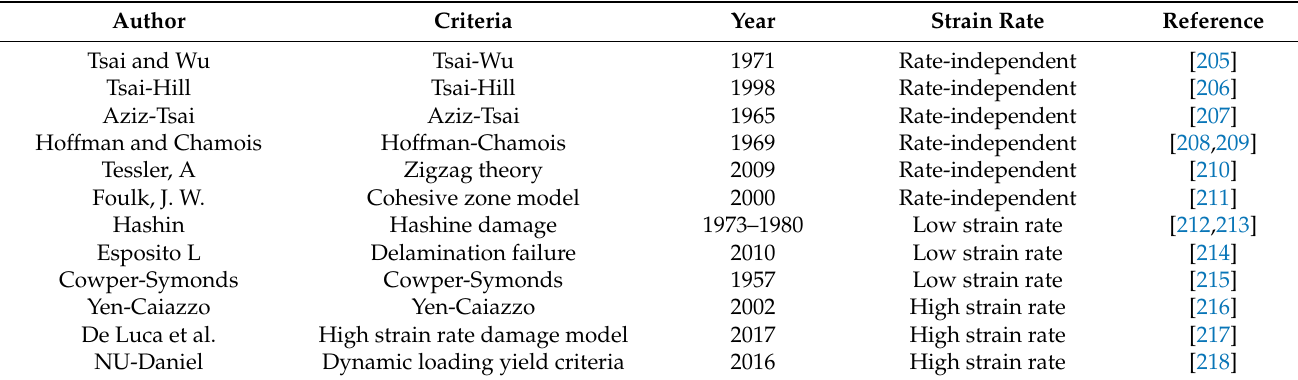
Table 3. Failure criteria for FRP composite laminates regarding strain rate dependency.